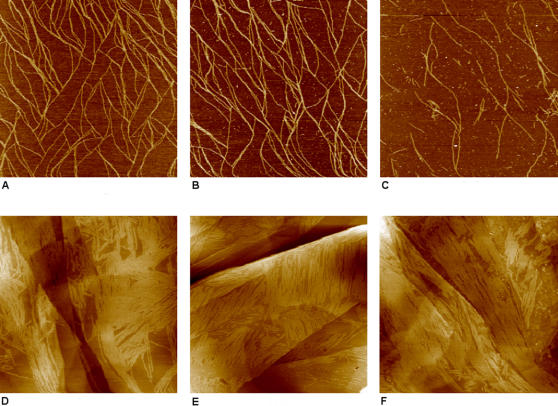
AFM images of EAK16-II modified mica and HOPG surfaces after immersion in pure water, 10 mM HCl and 10 mM NaOH solutions for 10 h.(a) mica, water; (b) mica, 10 mM HCl; (c) mica, 10 mM NaOH; (d) HOPG, water; (e) HOPG, 10 mM HCl; (f) HOPG, 10 mM NaOH. Scan areas are 2000 nm×2000 nm for mica and 1000 nm×1000 nm for HOPG.